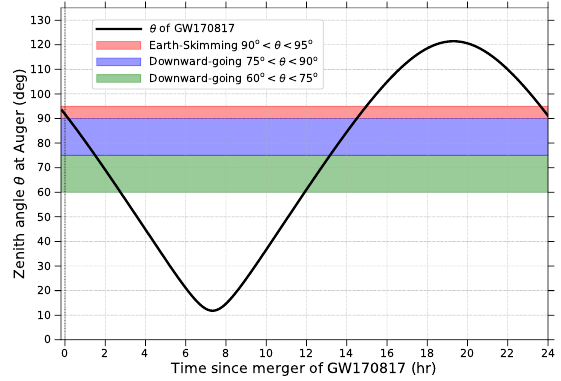
Figure 6. Zenith angle θ of the direction of the source of GW1701817 as viewed from the center of the Surface Detec- tor of the Pierre Auger Observatory in a period of one day. The band limits from top to bottom correspond to lines of zenith an- gles θ = 95 ◦ , 90 ◦ , 75 ◦ and 60 ◦ . The source of GW170817 transits along the sky from θ ∼ 11 . 8 ◦ to θ ∼ 121 . 4 ◦ in one day. It is in the field of view of the Earth-Skimming tau neutrino analysis during several periods in one sidereal day, in particular at the moment of emission of GW170817 (coincident with the origin of time in this figure).